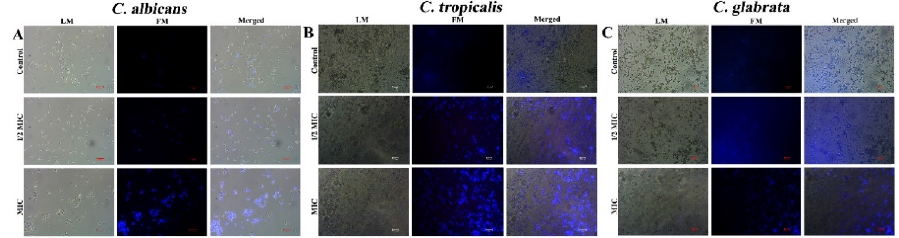
Figure 6. DNA damage induced by CTAC at different concentrations was analyzed by DAPI staining and examined under light and fluorescence microscopes. ( A ) C. albicans , ( B ) C. tropicalis and ( C ) C. glabrata . LM–light microscopic images; FM–florescence micrograph; merged—merged fluorescence and light micrograph. Magnification—200×; scale bar—50 μ m.